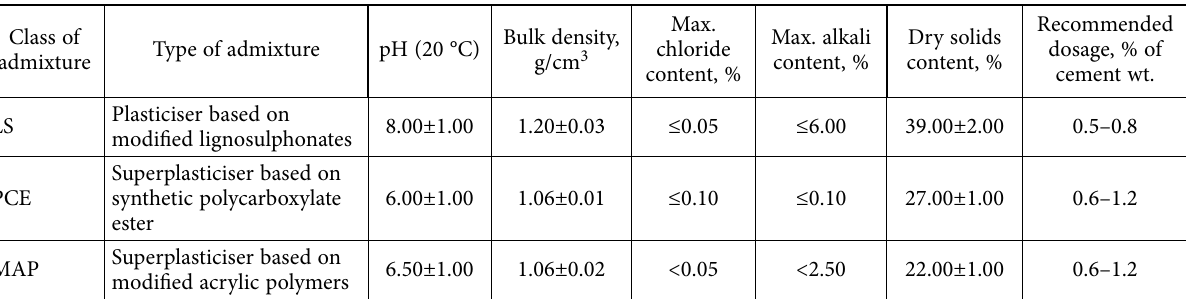
Table 2. Technical information on chemical admixtures